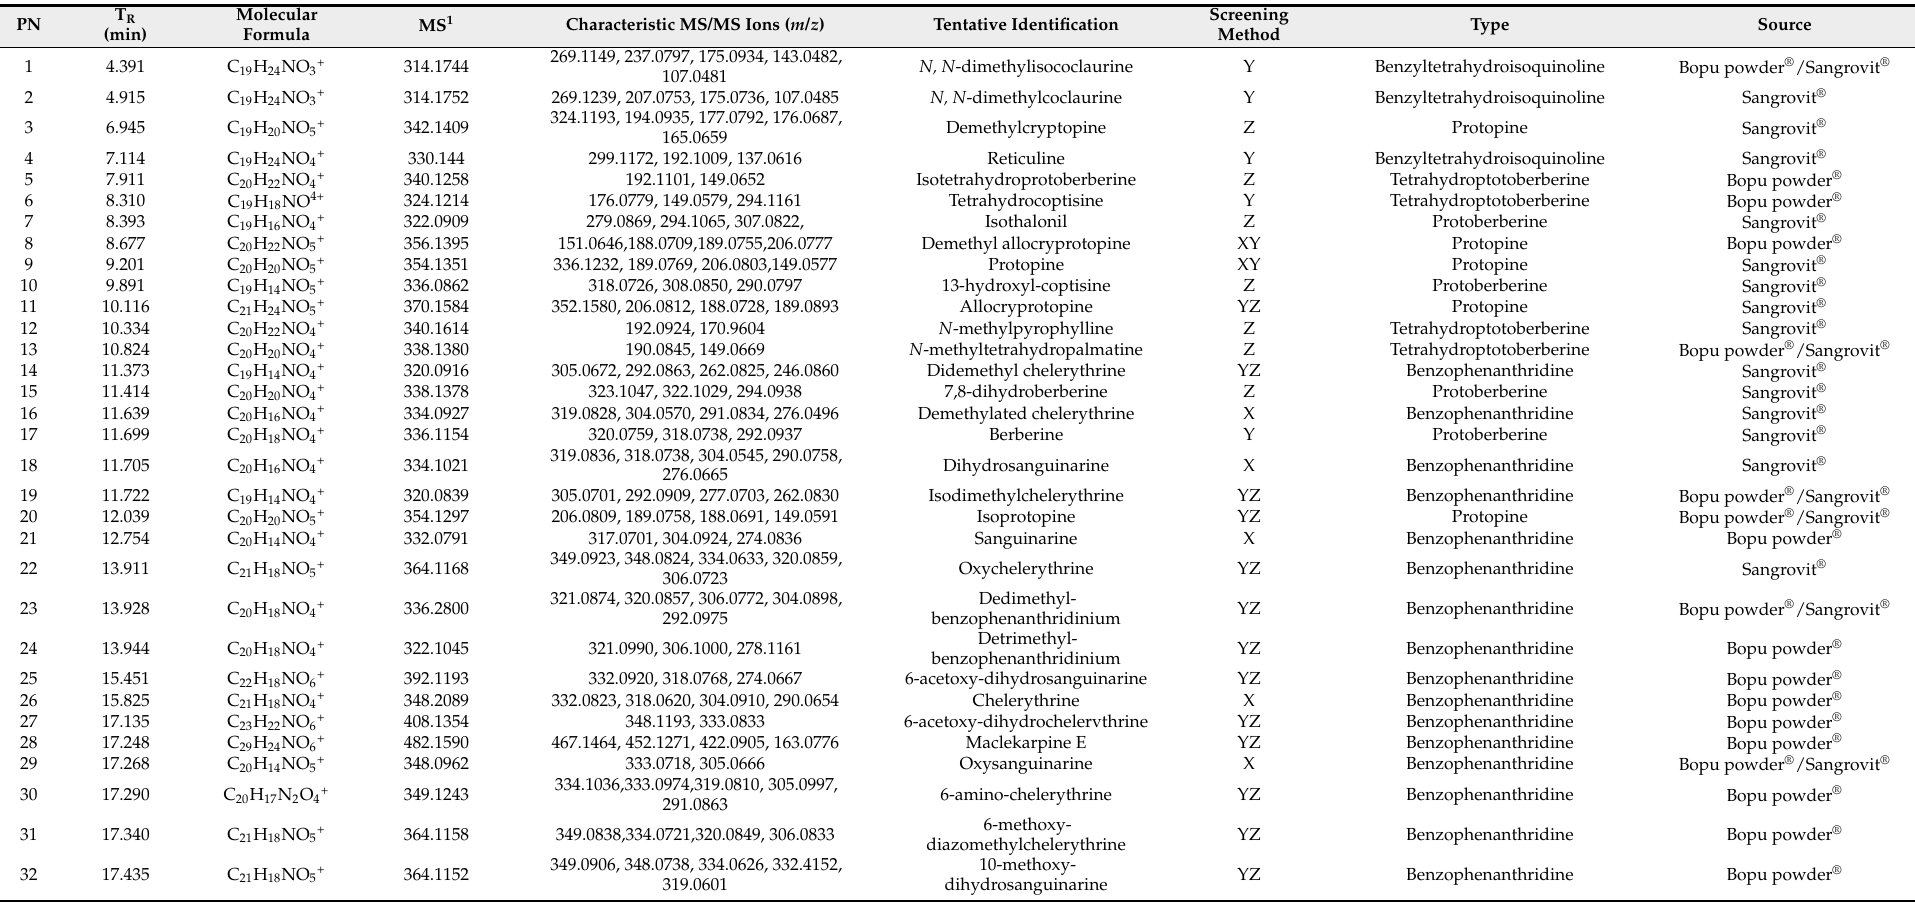
Table 1. Peak number (PN), retention time (T R ), molecular formula, MS 1 , characteristic MS/MS ions, tentative identification, screening method, type, and source of impurities. Those compounds were screened by the non-target method (X), accurate-target method (Y), and extensive-target method (Z). PN T R